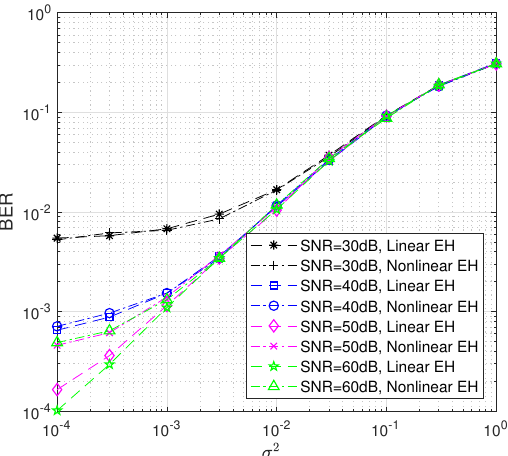
Figure 11. BER performance of the WP DH AF relaying system versus P T dB where P th = 35 dB, d sd =